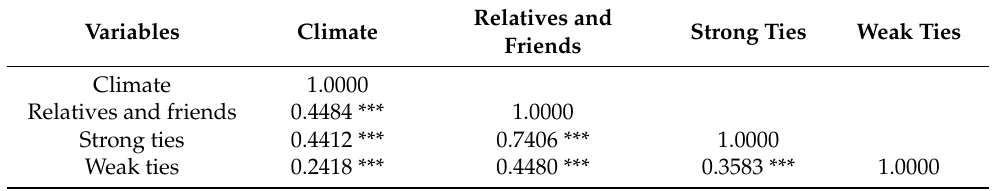
Table 1. Correlation analysis table of core variables. Relatives and Variables Climate Strong Ties Weak Ties Friends Climate 1.0000 Relatives and friends 0.4484 *** 1.0000 Strong ties 0.4412 *** 0.7406 *** 1.0000 Weak ties 0.2418 *** 0.4480 *** 0.3583 ***